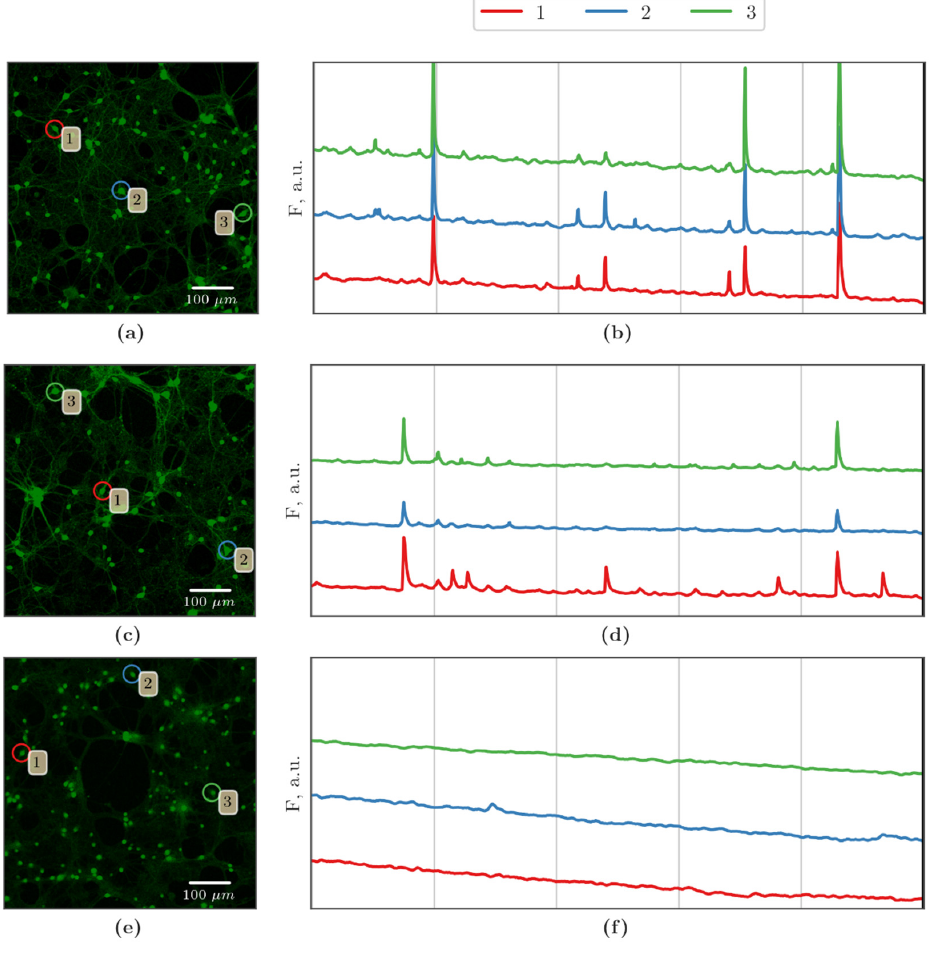
Figure 3. Representative recordings of spontaneous calcium activity of cells in primary cortical cul- tures on the third day of the post-hypoxic period: ( a , b ) Sham; ( c , d ) Gap19; ( e , f ) Hypoxia; ( g , h ) Hy- poxia+Gap19. Scale bars: 100 μ m. Our analysis did not reveal any pronounced negative effects of Cx43 blockade on the main parameters of calcium activity in primary cortical cells under normoxic conditions (Figures 3b and 4). Nevertheless, the cultures of the “Gap19” group showed a trend to- wards a decrease in the percentage of functionally active cells (69.57 ± 9.53%) relative to the sham values (90.79 ± 4.87%). Ca 2+ oscillations have, on average, a frequency of 0.24 ± 0.04 osc/min and a duration of 4.60 ± 1.17 s that formed a calcium activity profile close to that of the sham cultures (Figures 3 and 4) and corresponded to the values of primary hippocampal cultures in a normal state [32–35,37,40]. Hypoxia modeling caused significant changes in the functional calcium activity of primary cortical cultures. On day 3 of the post-hypoxic period, the percentage of active cells in the “Hypoxia” group (24.63 ± 10.65%) decreased dramatically relative to the sham values, by more than five times on average (Figure 4c). The blockade of Cx43 has a pro- nounced neuroprotective effect under hypoxic damage. On the third day of the post-hy- poxic period, the high percentage of functionally active cells (85.47 ± 12.62%) and the cal- cium activity profile remained in the “Hypoxia+Gap19” group at the intact level. Never- theless, there is a tendency to increase the duration of Ca 2+ oscillations, which can affect the network characteristics of cells in primary cortical cultures, which we analyzed fur- ther.